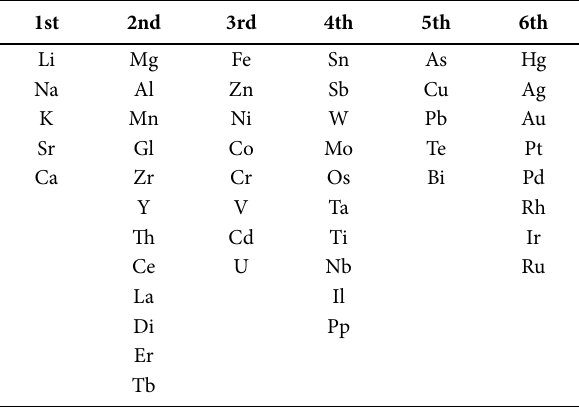
Table 2. Thénard’s & Régnault’s classification for metals in six sec- tions (authors’